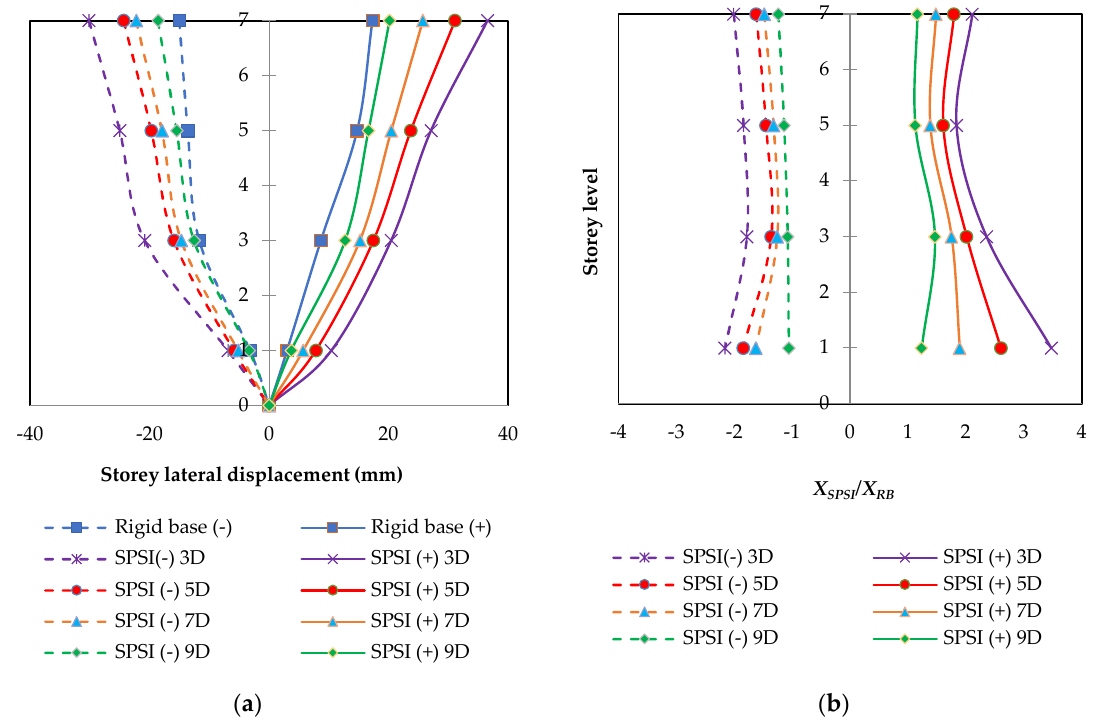
Figure 14. Effect of the S/D ratio on ( a ) story lateral displacement, and ( b ) X SPSI /X RB of the soil-pile-supported structural models, compared to the rigid-base structural model.